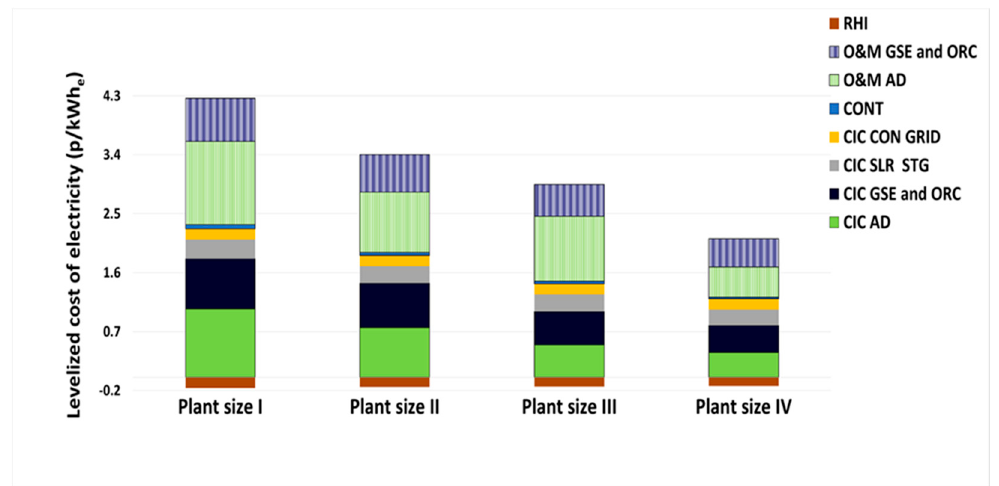
Figure 4. Levelized cost of electricity for the different individual plant sizes.